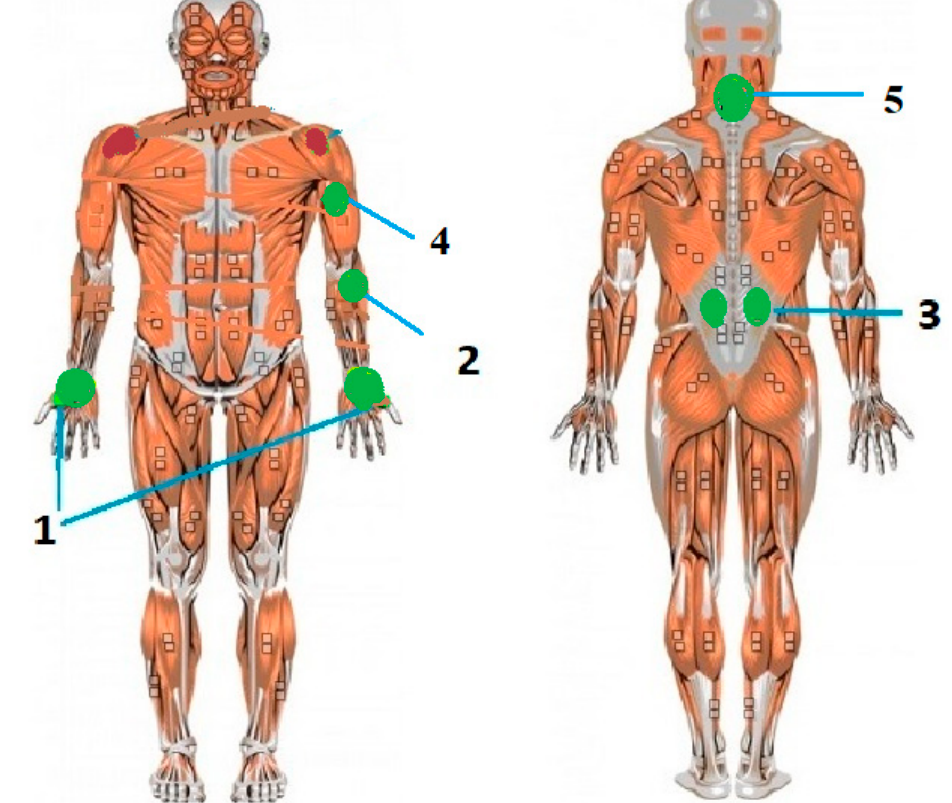
Figure 1. Muscle groups of examined farmers; 1—Interosseus, 2—Brachioradialis, 3—Latissimus dorsi, 4—Biceps brachii, 5—Neck extensors.